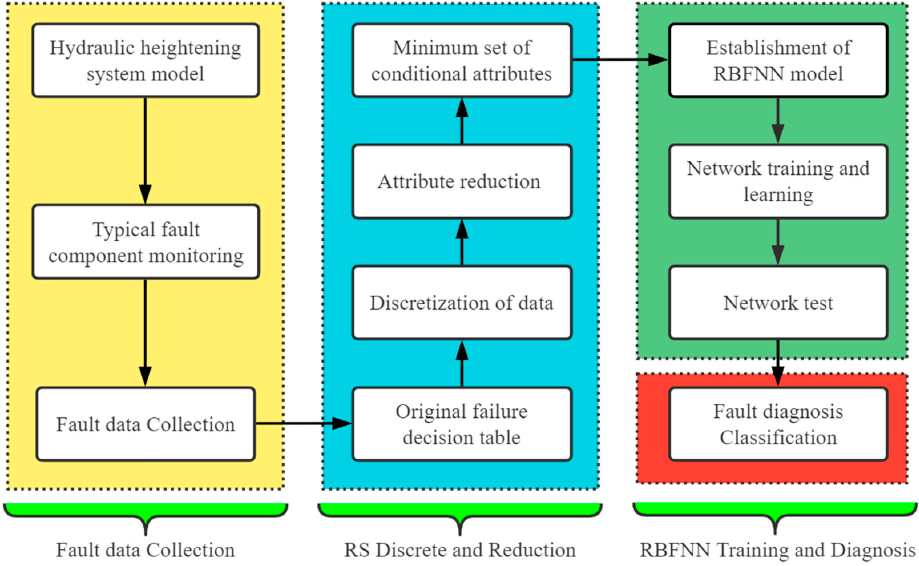
Figure 3. The flow chart of fault diagnosis model based on the RS-RBFNN.